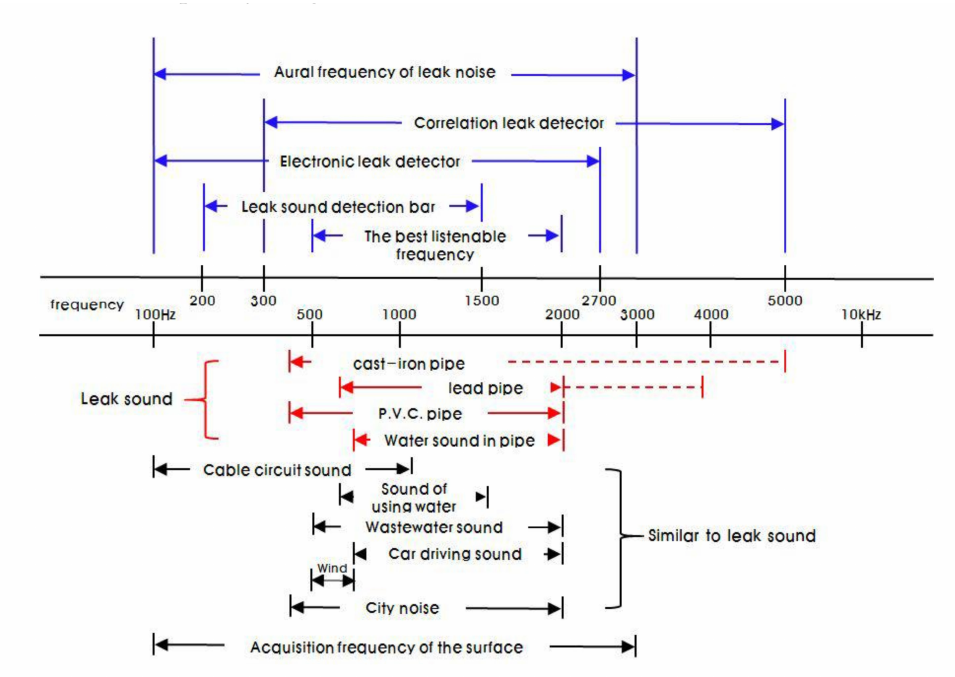
Figure 8. Audible range of leak detection equipment and frequency range of leak